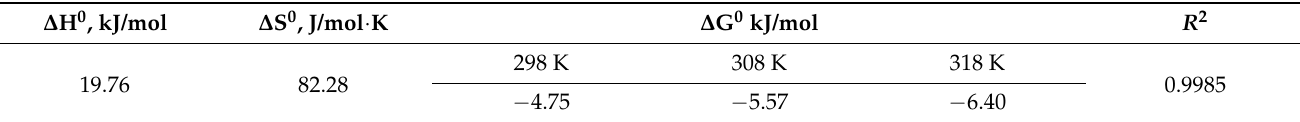
Table 5. Thermodynamic parameters.